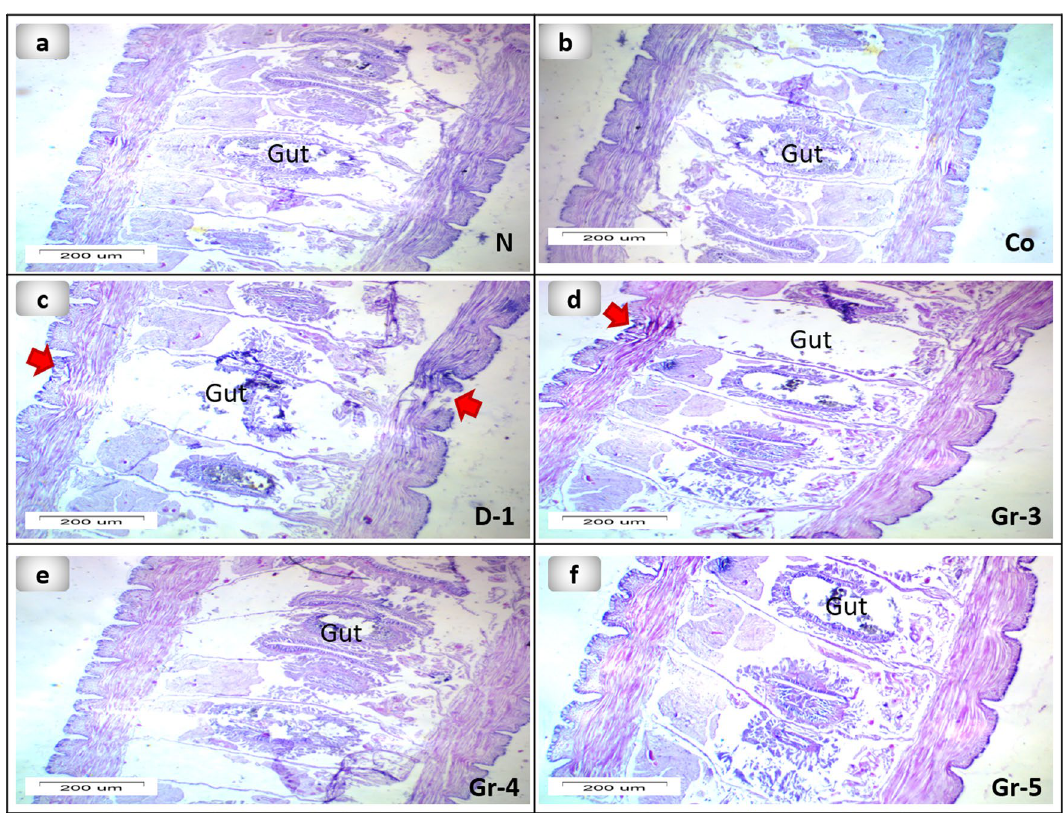
Figure 5. Photomicrographs of the longitudinal section of the different groups of earthworms ( Lumbricus castaneus ) after induction of surgical longitudinal wounds and examination of wound healing; ( a ) normal earthworm; ( b ) worms received Vaseline; ( c ) worm on the first day of injury, and ( d ) worms received 5 mg, ( e ) worms received 10 mg, ( f ) worms received 15 mg, note: the cells are loosely packed at the amputated region (raw). Hematoxylin and Eosin